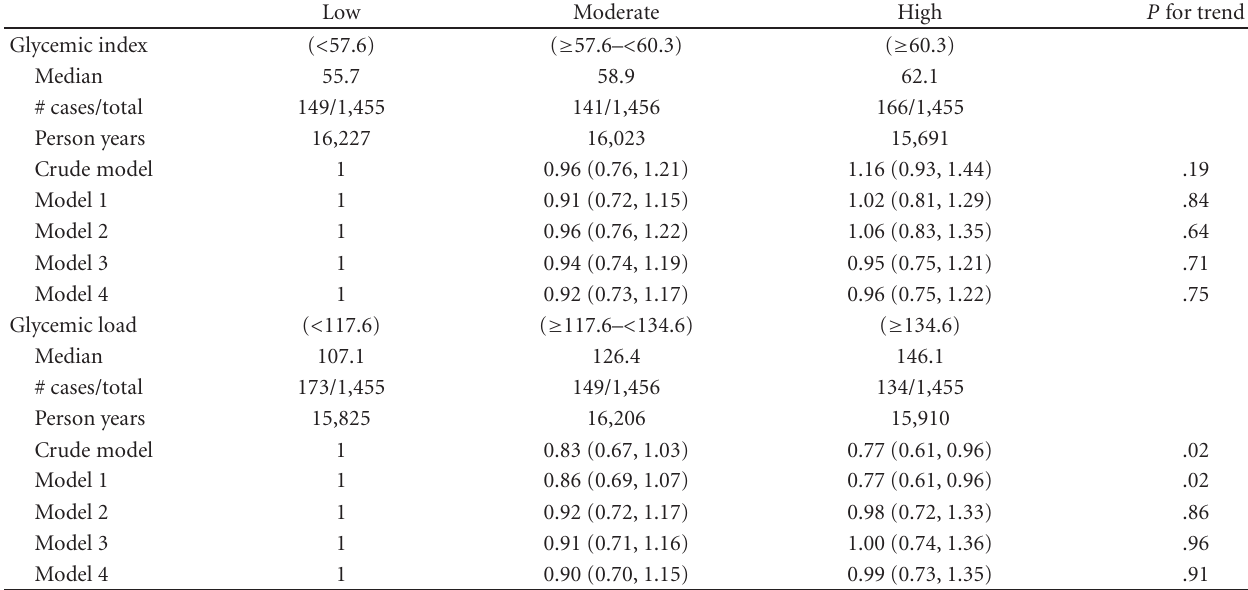
Table 3: Relative risks (95%CI) for incident type 2 diabetes by tertiles of energy-adjusted glycemic index and glycemic load in 4,366 Dutch adults aged ≥ 55